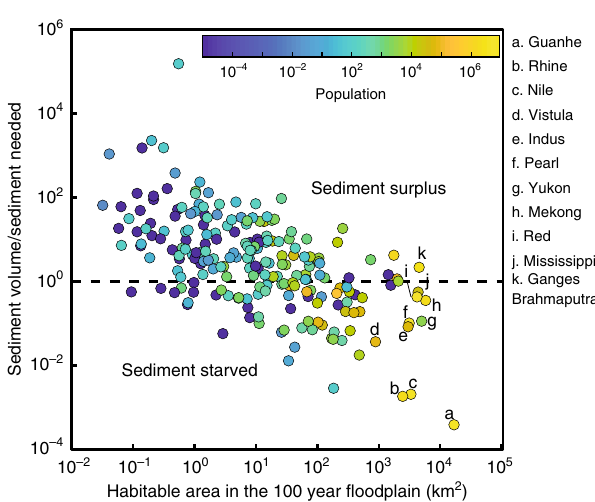
Fig. 4 Sediment-starved deltas contain more area and people in the 100- year fl oodplain. Sediment volume is the depositional volume created by 100 years of river sediment supply 52 with a porosity fraction of 0.4 and assuming 35% of incoming sediment is retained on the delta (ref. 35 ). Sediment needed is the volume of space between the 100-year storm surge elevation and the land surface elevation. Deltas with a value greater than one have a sediment surplus and may be able to aggrade their fl oodplain to the elevation of the 100-year storm surge, and those with value less than one are sediment starved. Each dot represents a delta that has a sediment discharge value ( n =